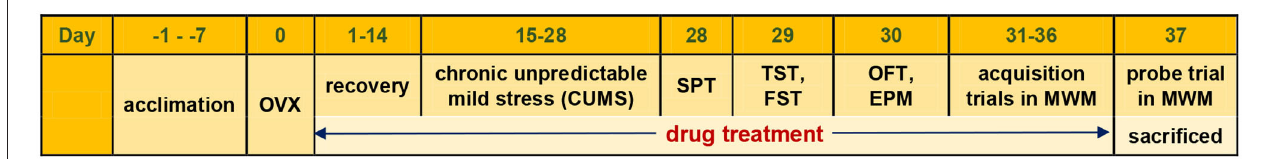
FIGURE 1 | Experimental time course. OVX, ovariectomized; SPT, sucrose preference test; TST, tail suspension test; FST, forced-swimming test; OFT, open-field test; EPM, elevated plus maze; MWM, Morris water maze.